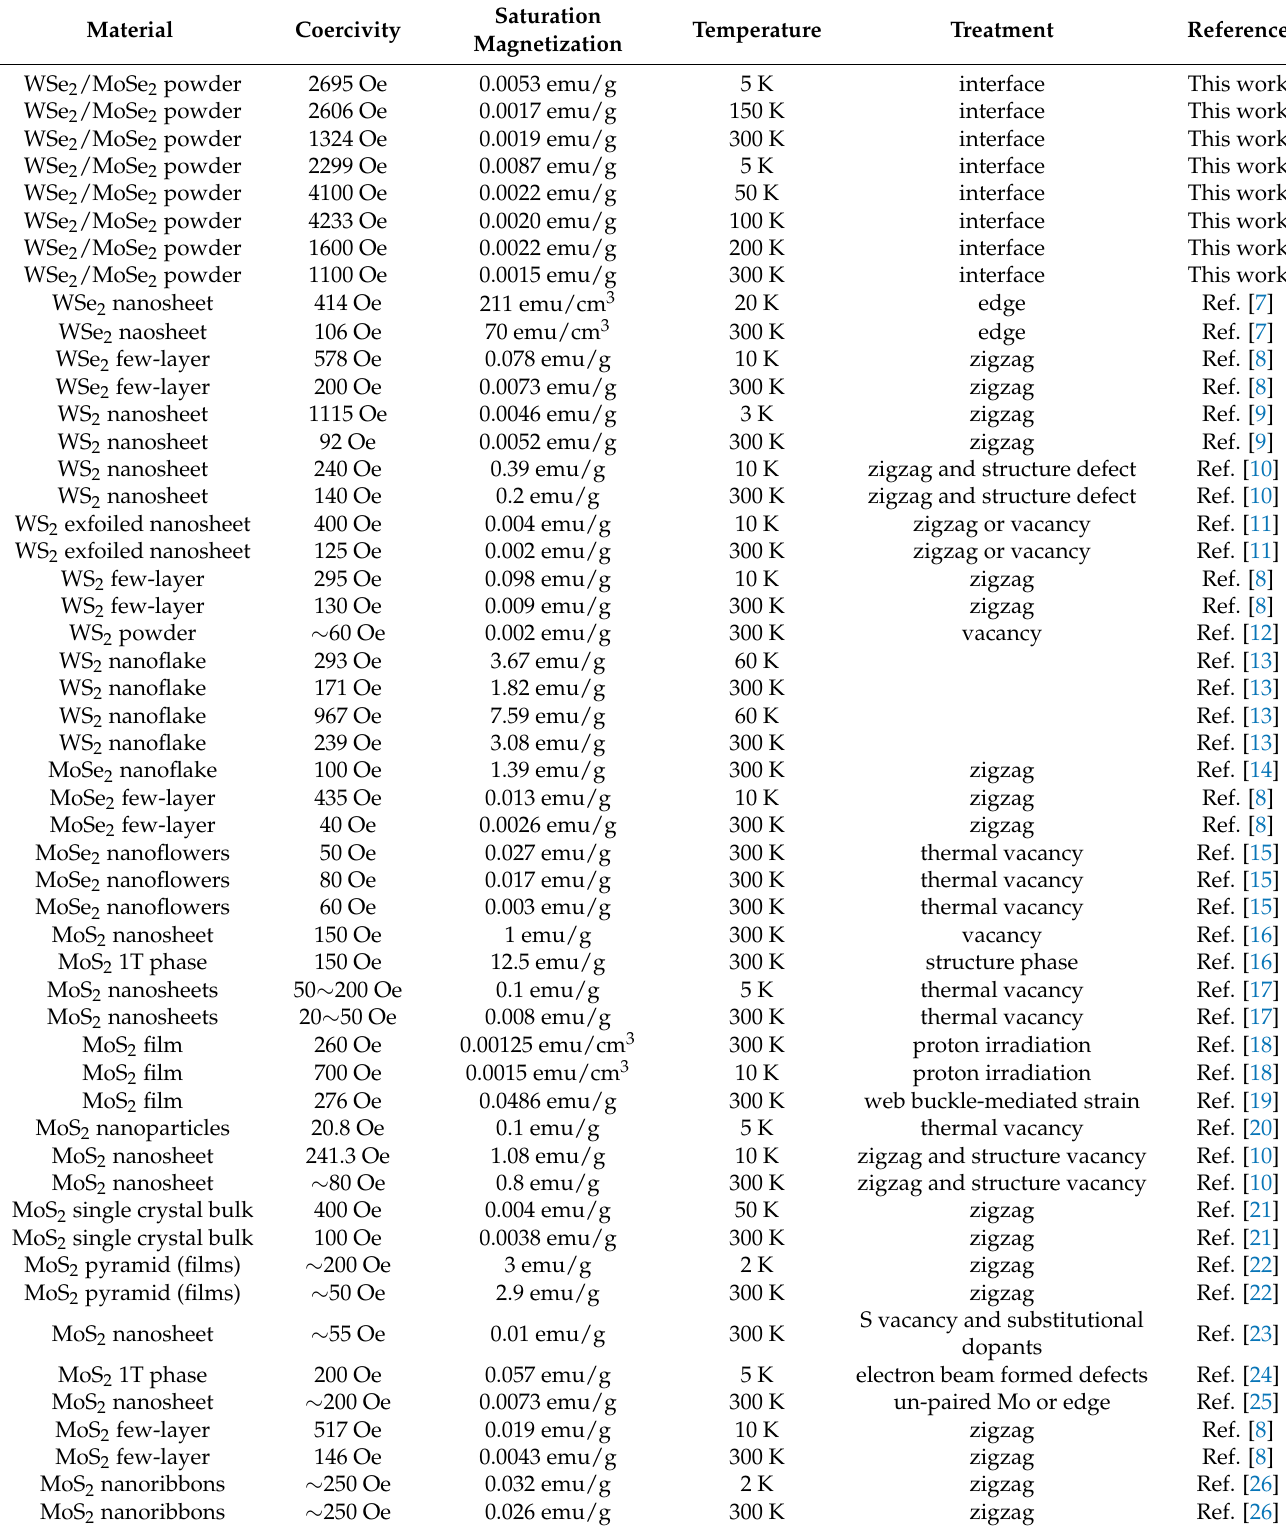
Table 1. List of the reported coercivity and saturation magnetization values of two-dimensional transition metal dichalco-